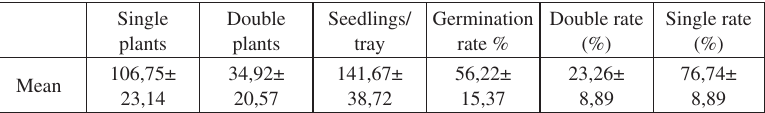
Table 2. Preliminary effectiveness rates of Sida h. neurs in tray method Single plants